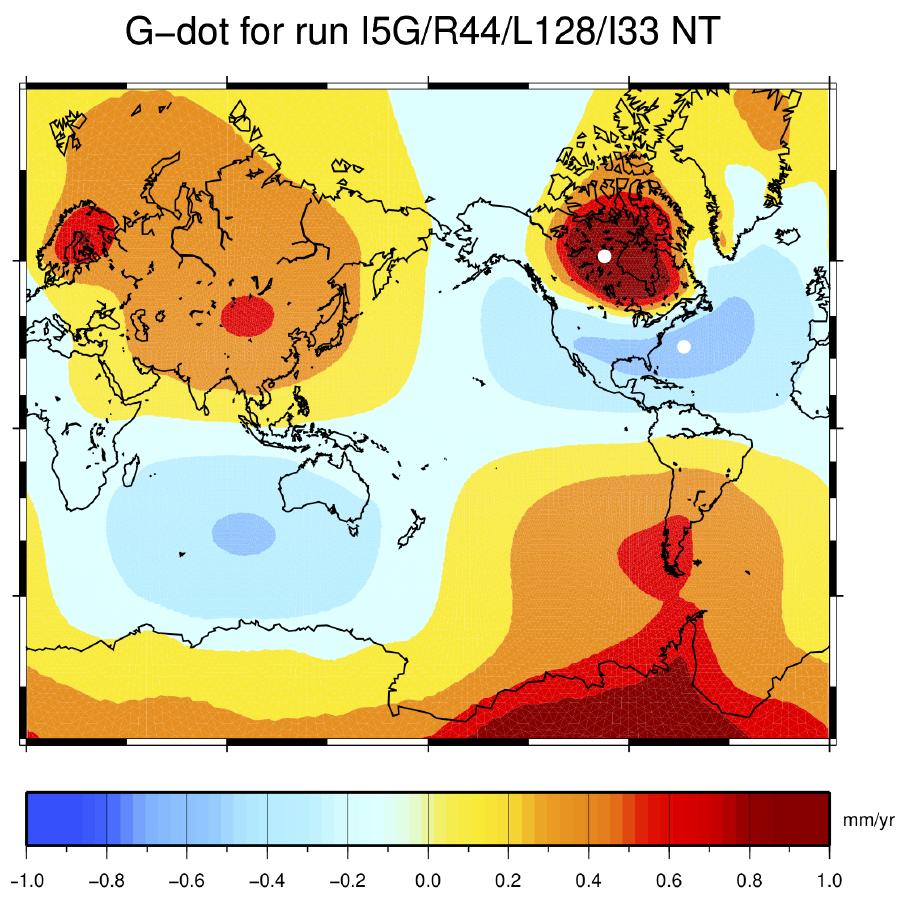
Figure 5. GIA fingerprint for ˙ i.e., the current rate of geoid height variation, according to our GIA G simulation based upon model ICE-5G (VM2). The white dots show where the largest rates are predicted, + 1.7 mm year − 1 , respectively. The regional variability in this map, with values of ˙ 0.6 and ˙ G ∼ − G ∼ i.e., the alternation of local minima and maxima, is drastically reduced in comparison with ˙ giving to ˙ a very smooth G